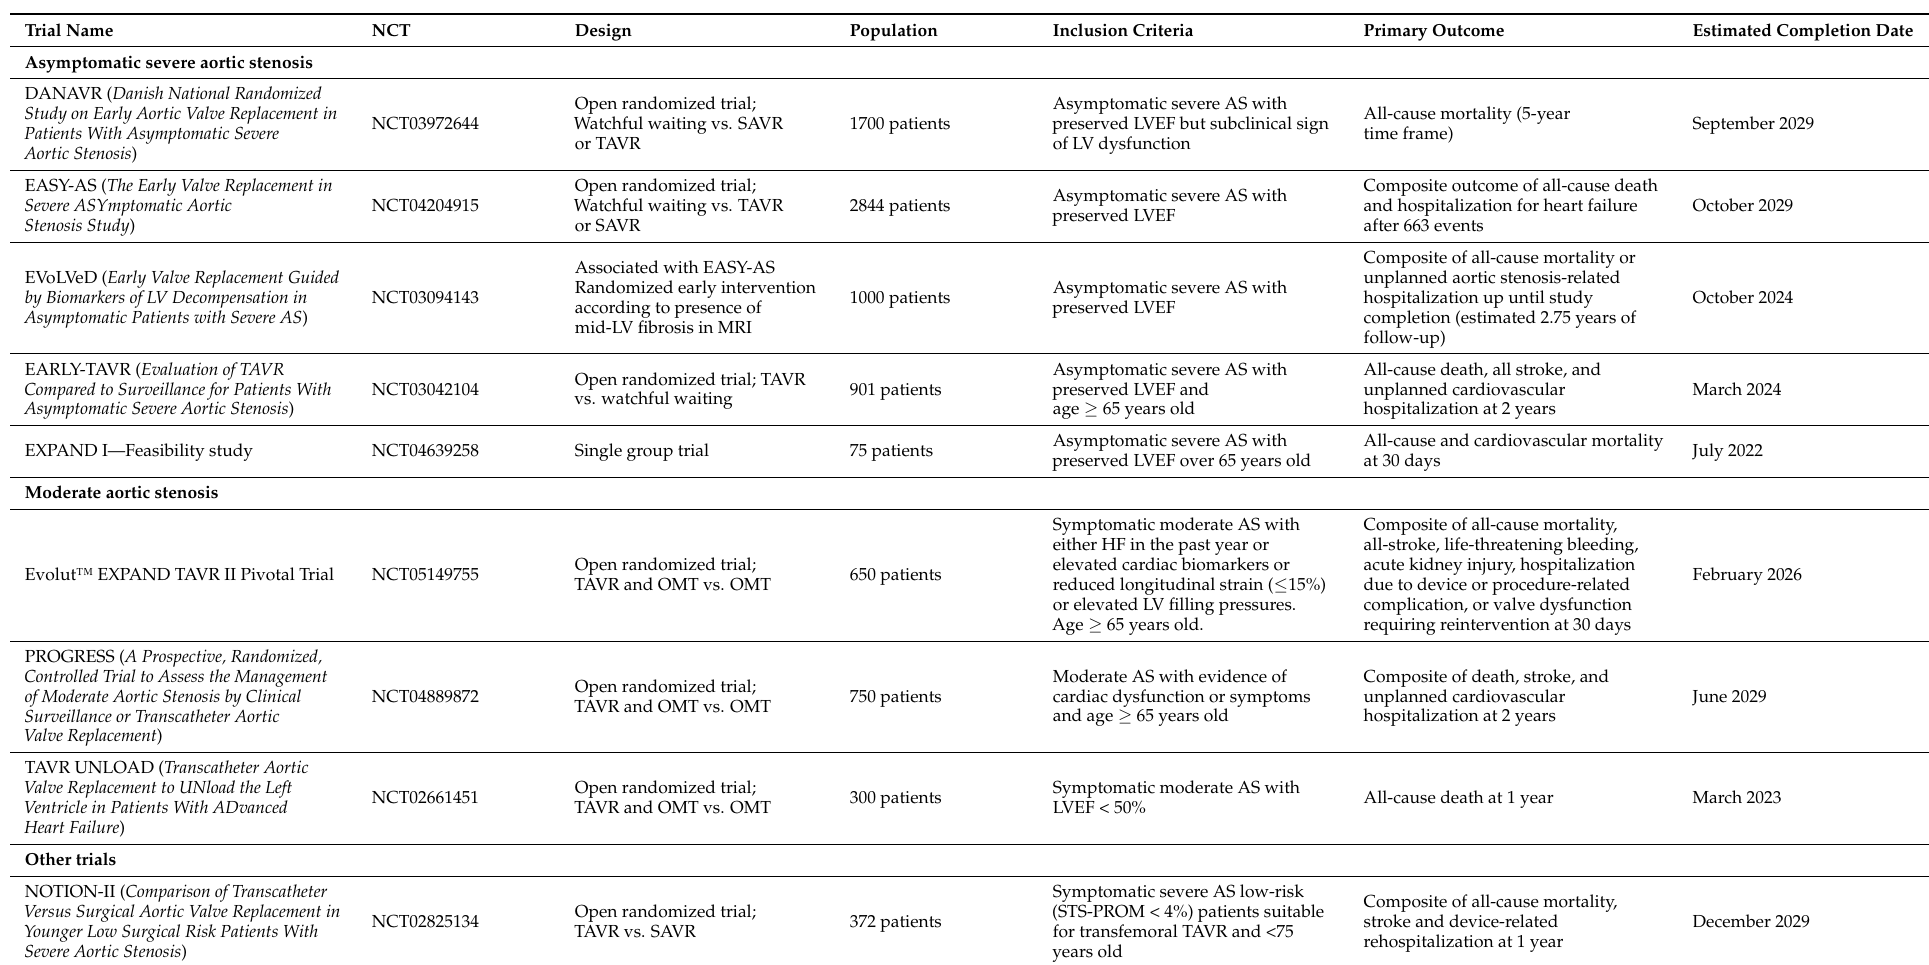
Table 3. Current trials aiming to expand TAVR